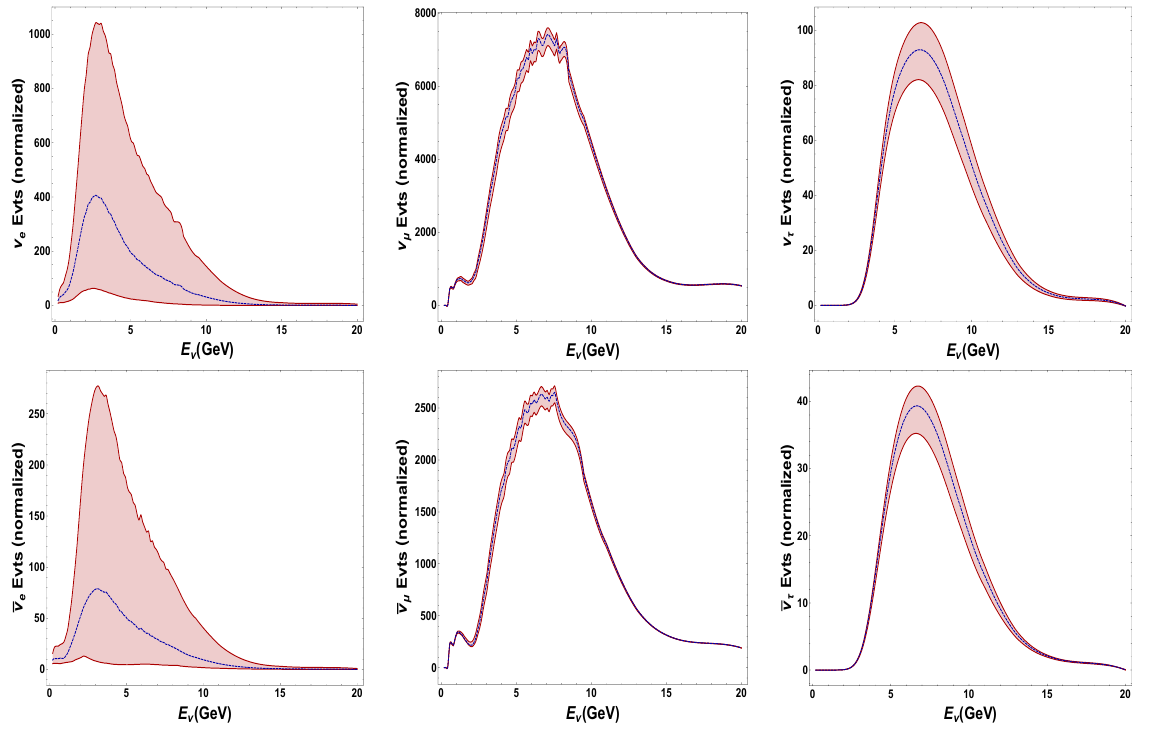
Figure 2. Same as Figure 1 but using the τ -optimized